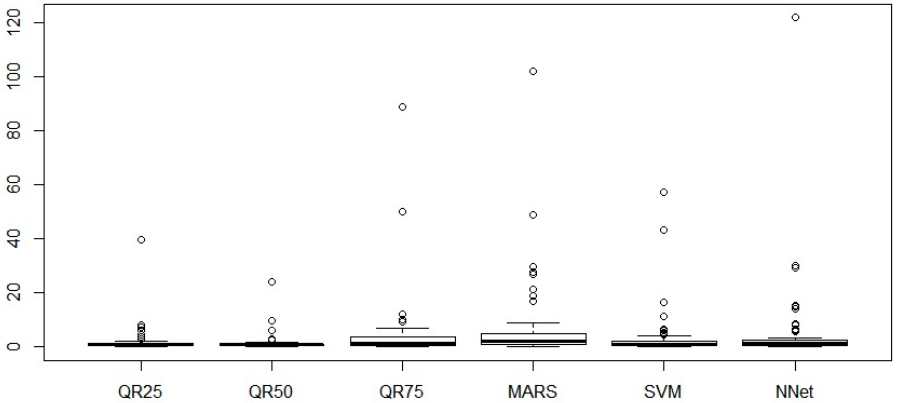
Figure 5. Boxplots of the Absolute Percentage Errors of ROI for Each Model for Year 2015 with 2010–2014 Years data (out of sample forecast).